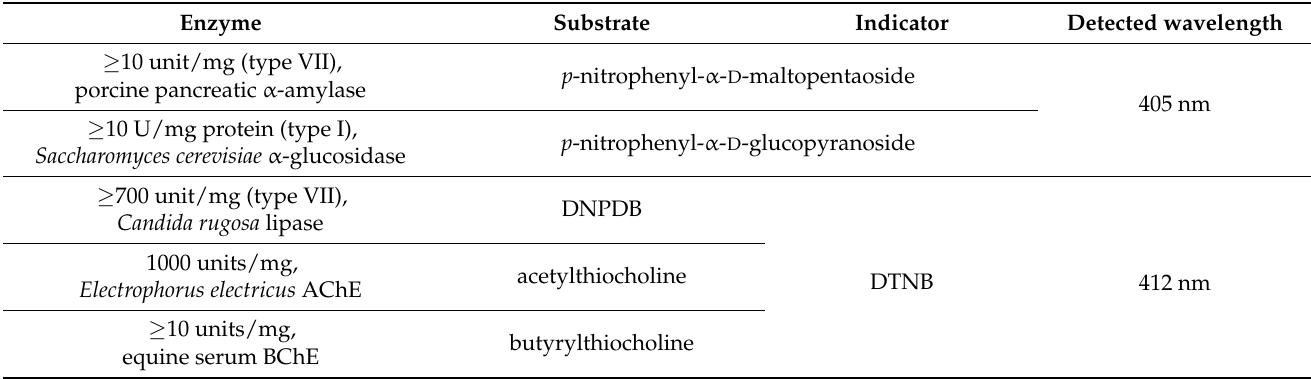
Table 5. The compositions and detecting wavelengths of enzyme